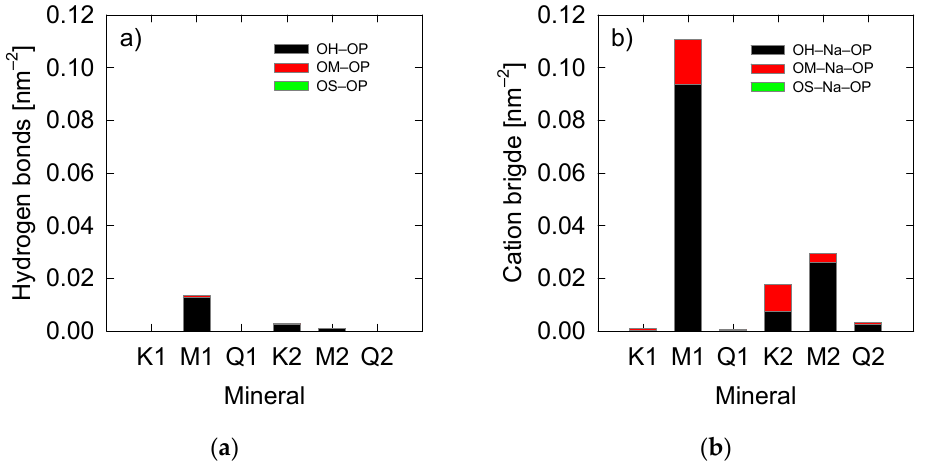
Figure 3. PAA-mineral interactions ( a ) hydrogen bond and ( b ) cation bridging. K1, M1, and Q1 are at 0.06 M salt concentration. K2, M2, and Q2 are at 0.6 M salt concentration. OP: deprotonated PAA oxygen, OH: hydroxide oxygen, OM: deprotonated kaolinite oxygen, OS: surface neutral oxygen.